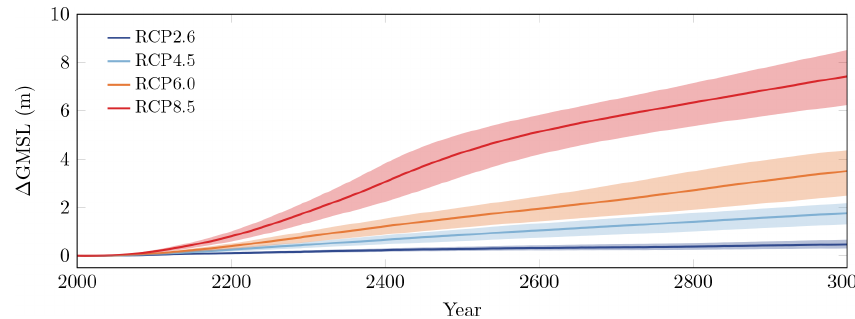
Figure 13. Same as Fig. 6 but under the TGL parameterisation and the weakly non-linear sliding law. Table 5. Same as Table 3 but with the TGL parameterisation. (cid:49) GMSL projections are the median projections with their 5%–95% probability intervals between